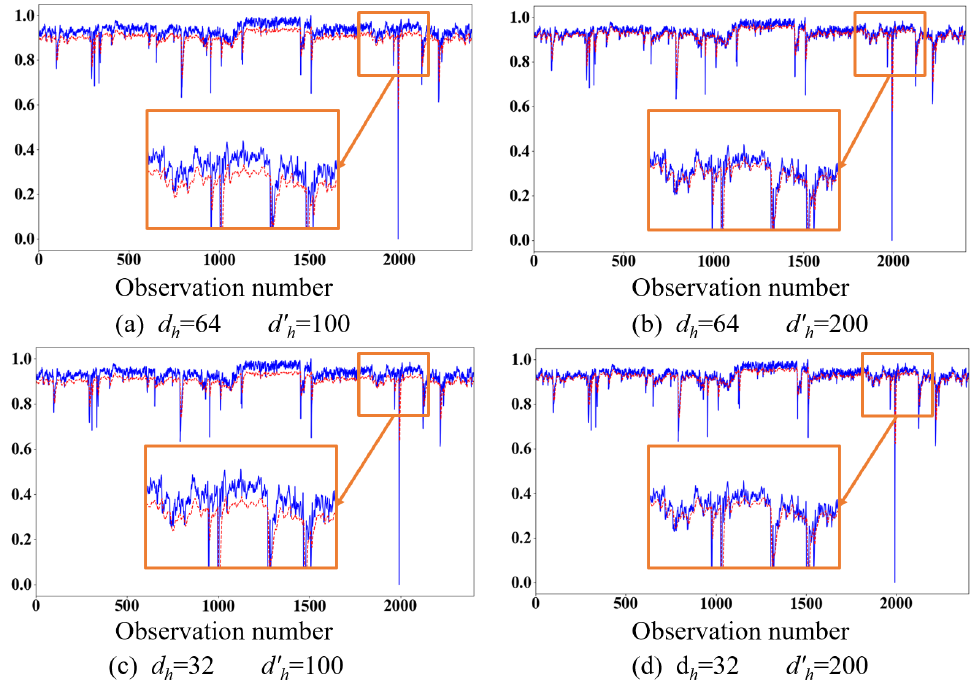
Figure 5. Prediction results for u 1 using models with different parameter settings (the red line corresponding to predictions, the blue line corresponding to true values). ( a ) Prediction results for = 100; ( b ) Prediction results for u = 64 and d (cid:48) = 200; ( c ) Prediction u 1 with d h = 64 and d (cid:48) 1 with d h h h = 100; ( d ) Prediction results for u = 32 and d (cid:48) = 100. results for u 1 with d h = 32 and d (cid:48) 1 with d h h h